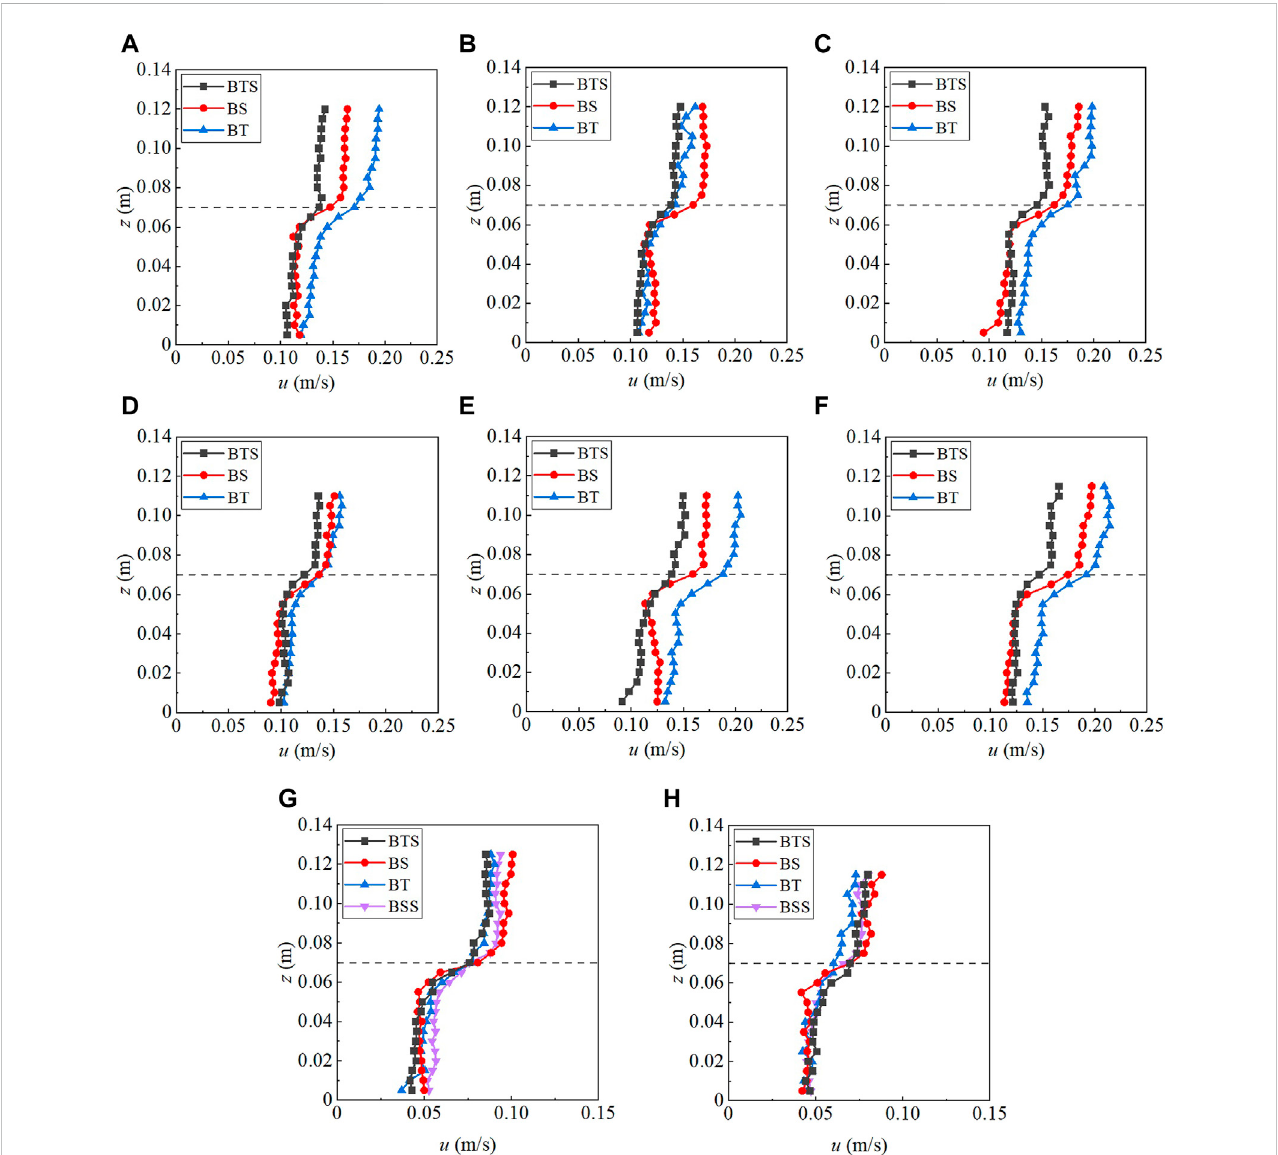
FIGURE 4 Vertical pro fi les of longitudinal velocity at different measurement locations for runs X and runs Y, (A – C) present results for runs XHS1 to XHS3, (D – F) present results for runs XLS1 to XLS3, (G,H) present results for runs YHS1 and YLS1, respectively. The black dotted line represents the height of the short